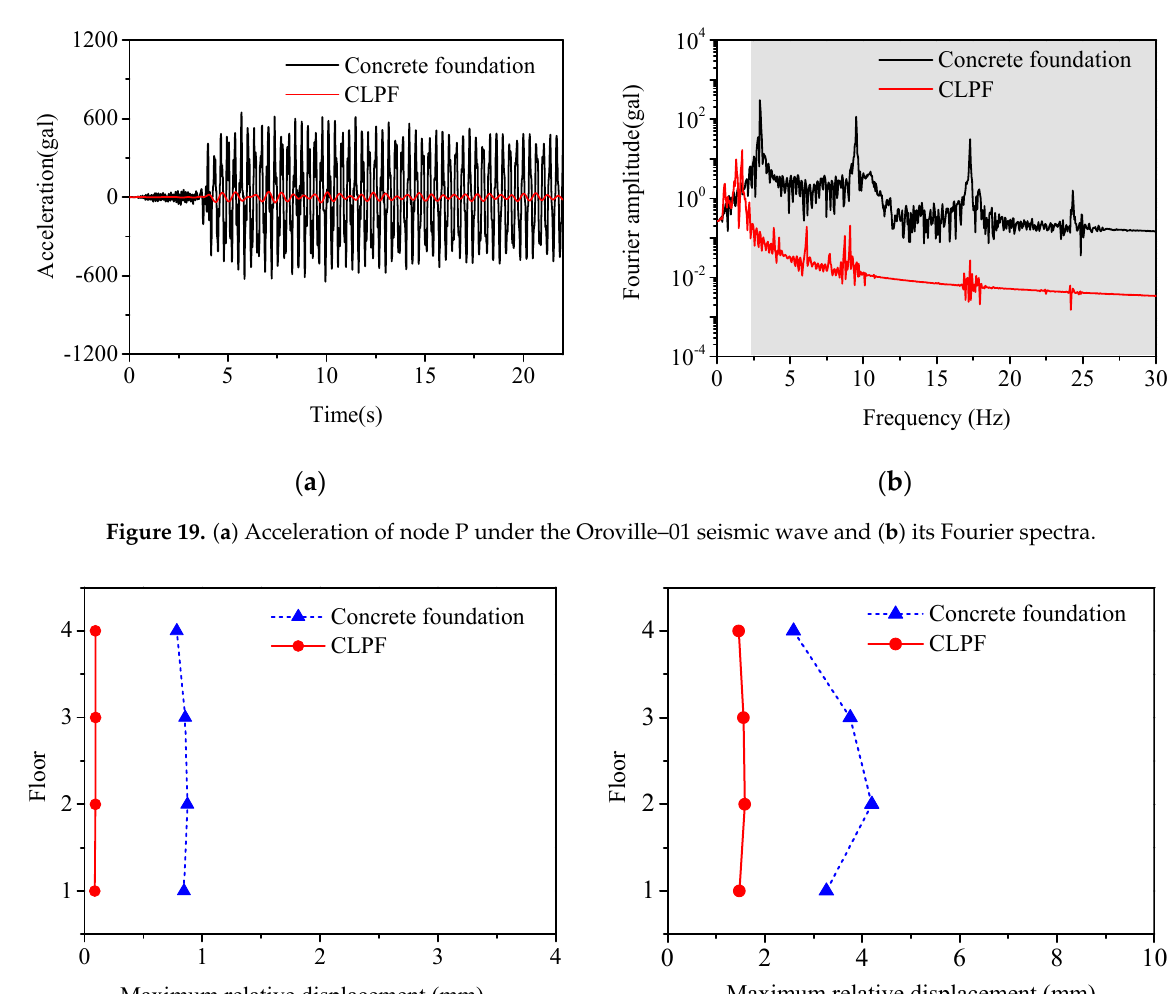
Figure 18. ( a ) Acceleration record of the Oroville–01 seismic wave and ( b ) its Fourier spectra.